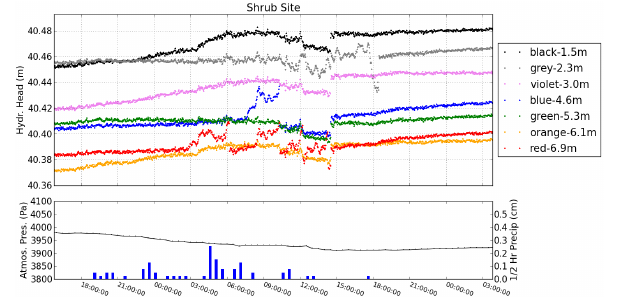
Fig. 7. Fluctuations in hydraulic head at the shrub site (i) on 20 Oc- tober 2011, believed to be ebullition events occurring during a strong drop in atmospheric pressure and a low-precipitation event. The pressure release lasts for different lengths of time at different depths of peat. The pressure fluctuations move upward in the peat column at 07:00EDT.